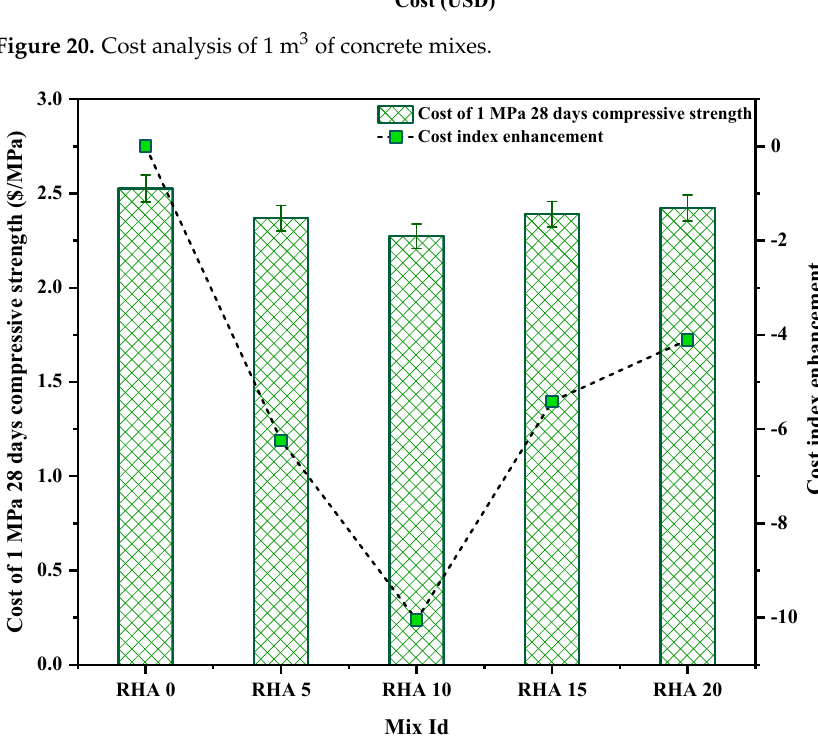
Figure 20. Cost analysis of 1 m 3 of concrete mixes.